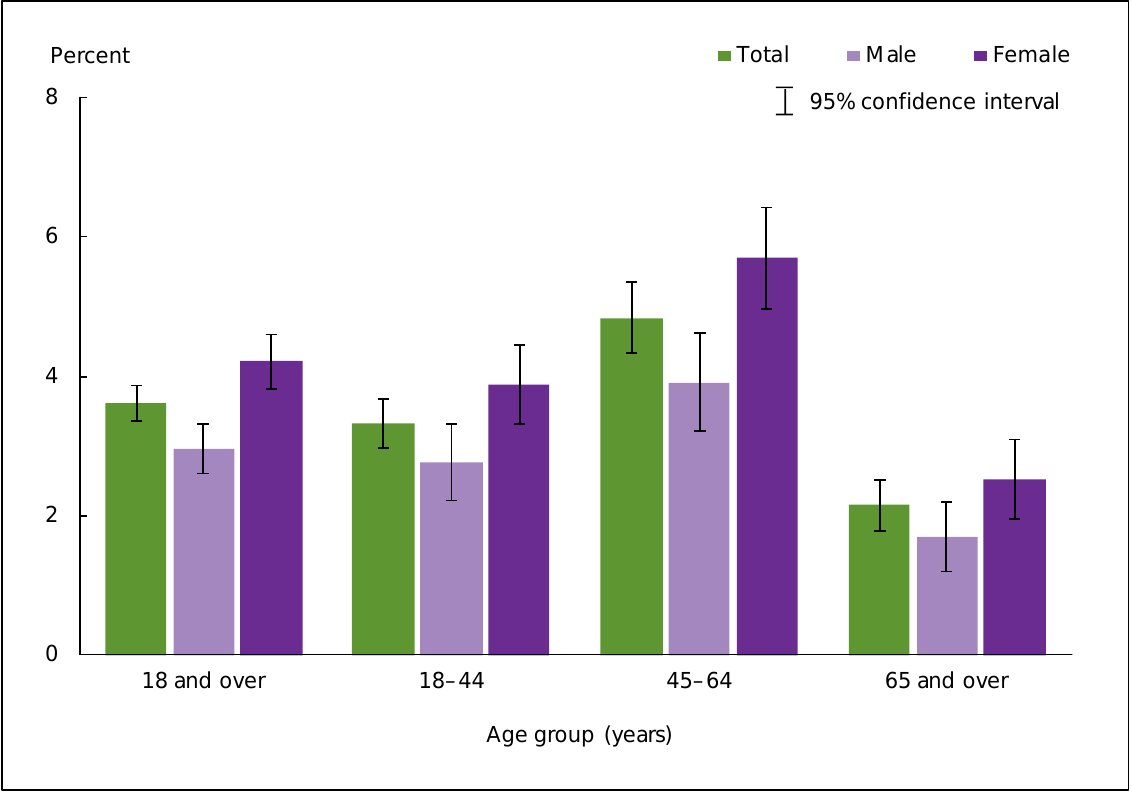
Figure 13.2. Percentage of adults aged 18 and over who experienced serious psychological distress during the past 30 days, by age group and sex: